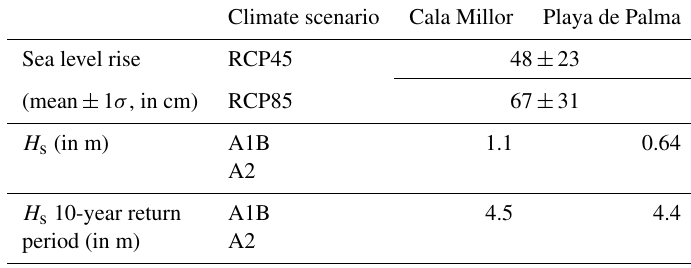
Table 1. Input condition of the model set-up under climate change scenarios for the two beaches. See the text for details on their